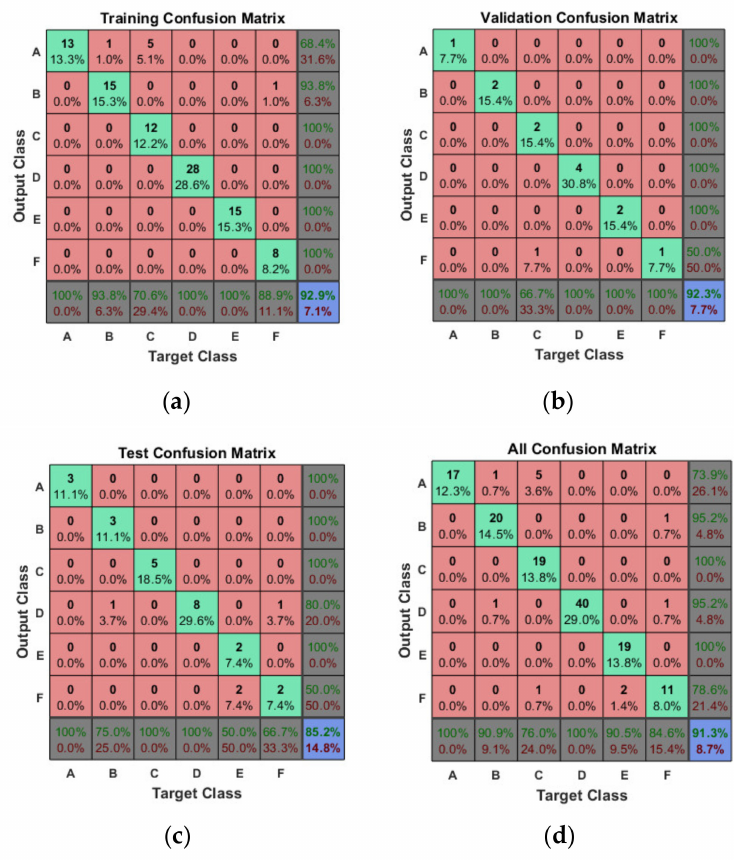
Figure 21. The confusion matrices of ANN trained with CCF feature set: ( a ) training confusion